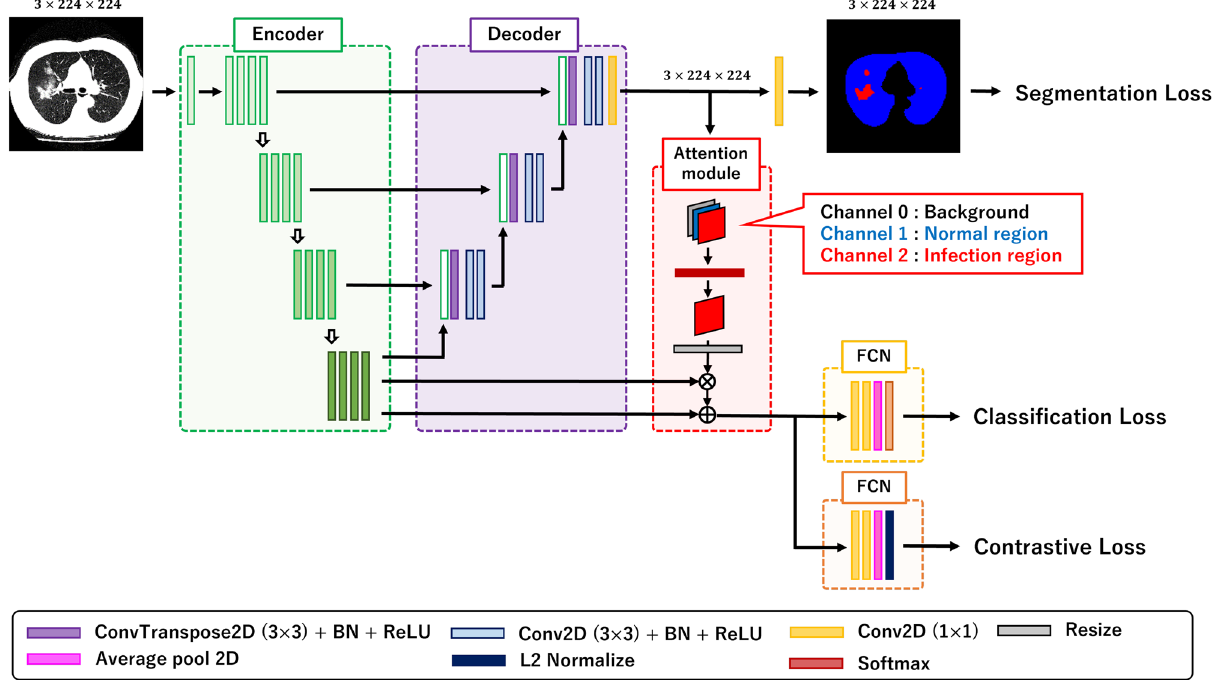
Figure 2. Overview of network structure. The proposed method is based on the U-Net architecture. The encoder consists of ResNet18, the output has high dimensional features, and the decoder outputs a segmentation map. The features extracted from ResNet18 are fed into two fully convolution networks (FCNs), and we obtain two types of vectors for classification and contrastive learning. The attention module also teaches the information of infection regions for two FCNs. A ground truth of a semantic segmentation includes three categories. A black region is a background category, and blue and red regions are normal and infection